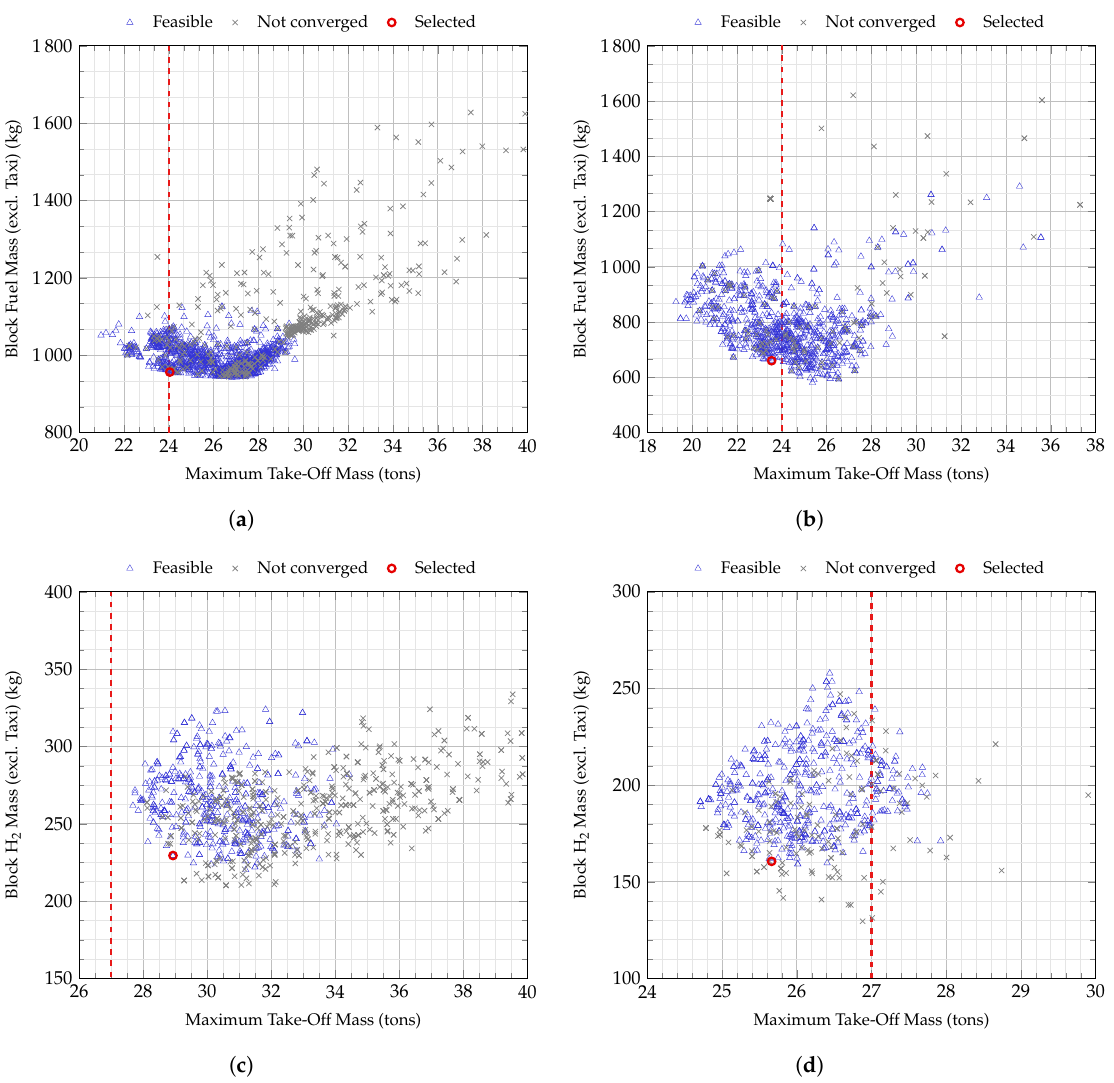
Figure 8. Selected values for DOE independent variables. Red dotted lines indicate the recommended upper threshold of the MTOM for the different scenarios. ( a ) Short-term ICE + battery. ( b ) Medium- term ICE + battery. ( c ) Medium-term PEMFC + battery. ( d ) Long-term SOFC +